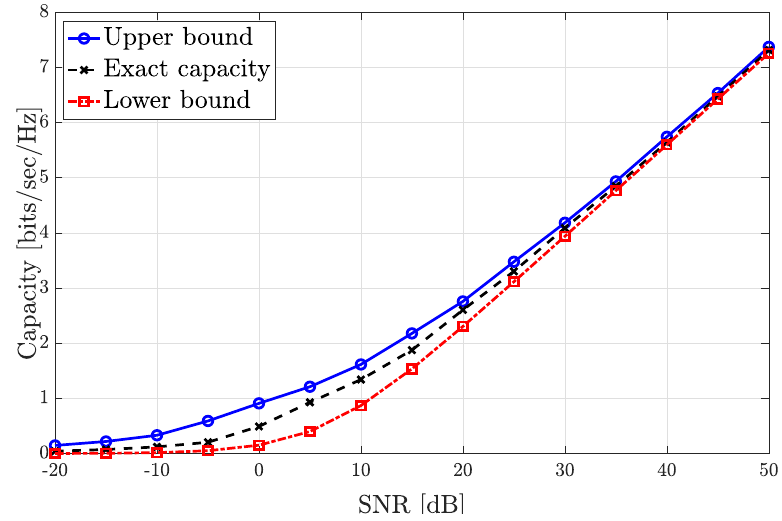
Figure 18. Exact, upper and lower capacity bounds for amplitude constrained Gaussian